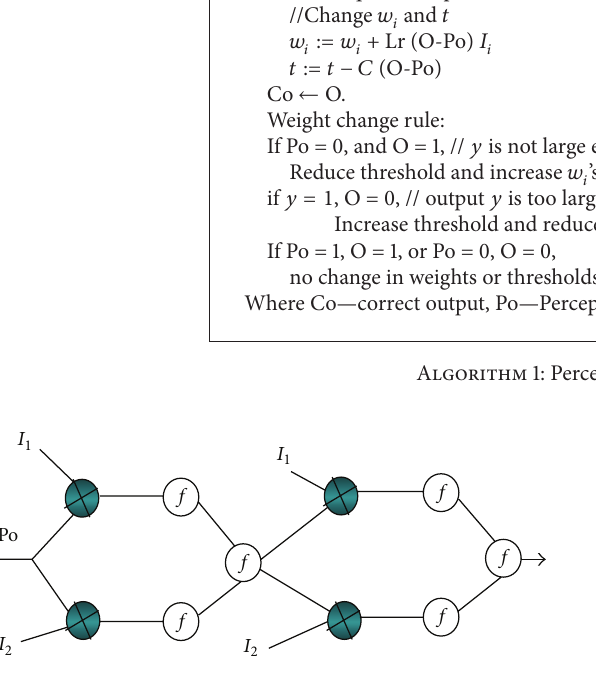
Figure 1: One cell of network